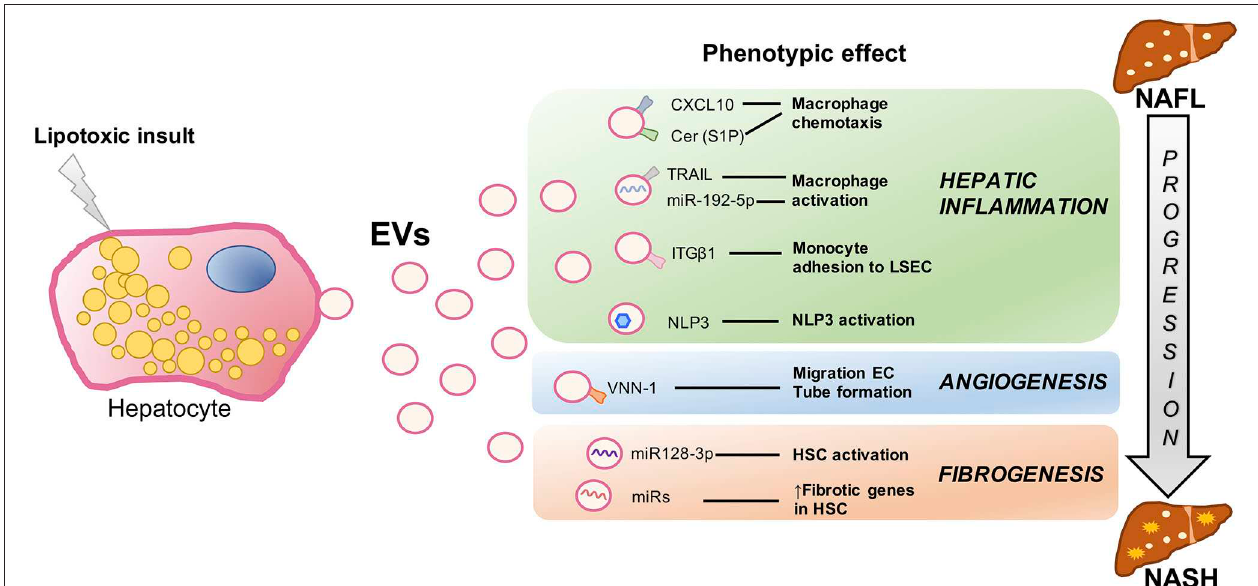
FIGURE 2 | Signaling events mediated by extracellular vesicles during hepatocyte lipotoxicity. Hepatocyte injury induced by lipotoxicity triggers the release of EVs (Hep-EVs) that drive the response of surrounding cells playing an important role during NAFLD progression to NASH such as hepatic inflammation, dysregulated angiogenesis, and fibrosis. Recent in vitro and in vivo studies have defined multiple Hep-EV cargos responsible of different phenotypic effects in the target cells. CXCL10 and ceramide-enriched EVs mediate monocyte/macrophage chemotaxis to the liver, whereas TRAIL-enriched EVs and miR192-5p contribute to macrophage activation. ITG β -enriched EVs regulate monocyte adhesion to LSECs, and Hep-EVs can also activate NLRP3 inflammasome. VNN1-1–bearing EVs mediate endothelial cell migration and tube formation and neovascularization, whereas miR-128-3p–laden EVs induce HSC proliferation and activation. EV, extracellular vesicles; CXCL10, C-X-C motif chemokine ligand 10; Cer, ceramide; S1P, sphingosine 1-phosphate; TRAIL, tumor necrosis factor–like apoptosis inducing ligand; ITG β 1, integrin β 1, LSEC, liver sinusoidal endothelial cells; NLRP3, nucleotide-binding oligomerization domain-like receptor protein 3; VNN1, vanin-1; EC, endothelial cells; HSCs, hepatic stellate cells; NAFLD, nonalcoholic fatty liver; NASH, nonalcoholic